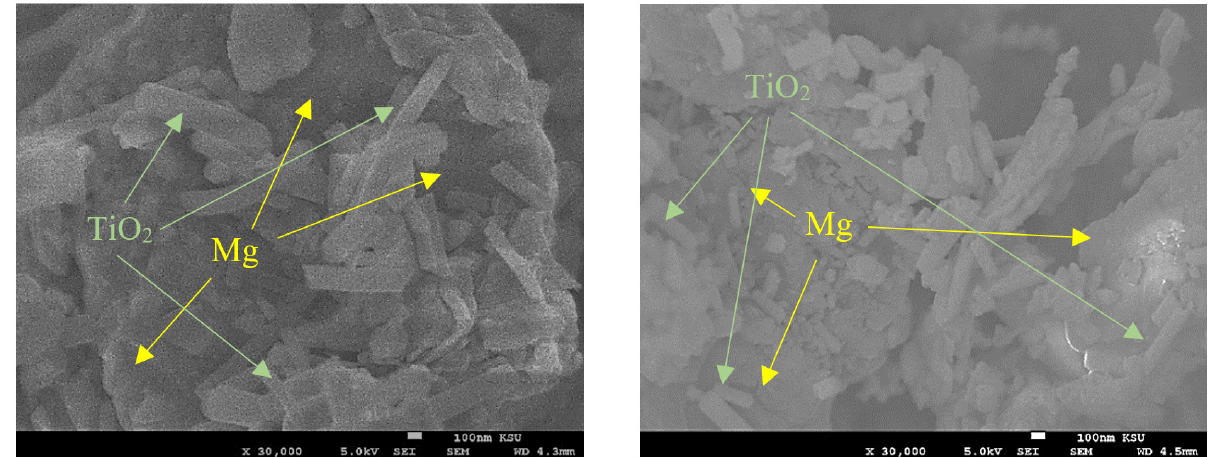
Figure 5. SEM images of ball ‐ milled Mg/TiO 2